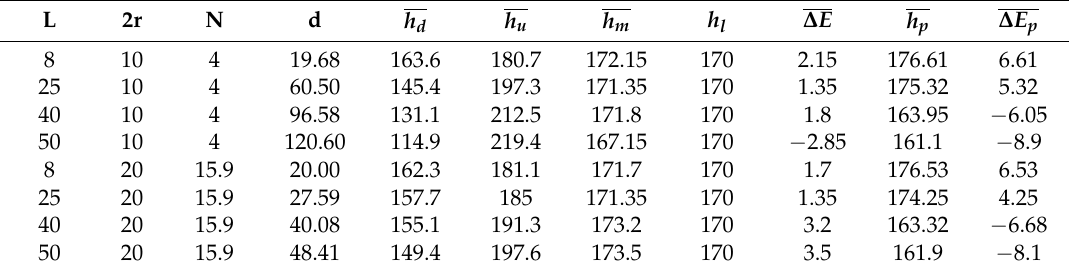
Table 2. The result of measurements using two different diameters of sensors and PLI indicator (mm).